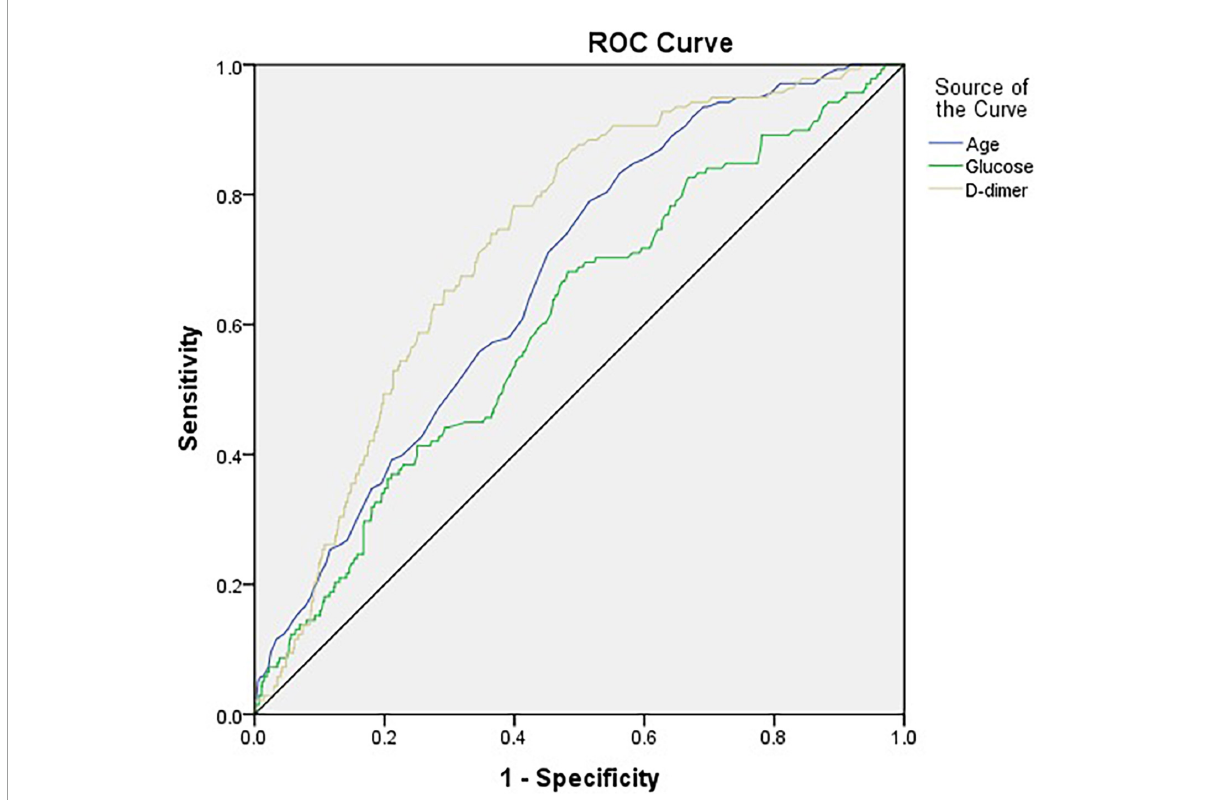
FIGURE2 The horizontal axis indicates the 1-specificity, and the vertical axis indicates the sensitivity of each variable in predicting DVT. The area under the curve (AUC) represents the respective ability to discriminate DVT cases.